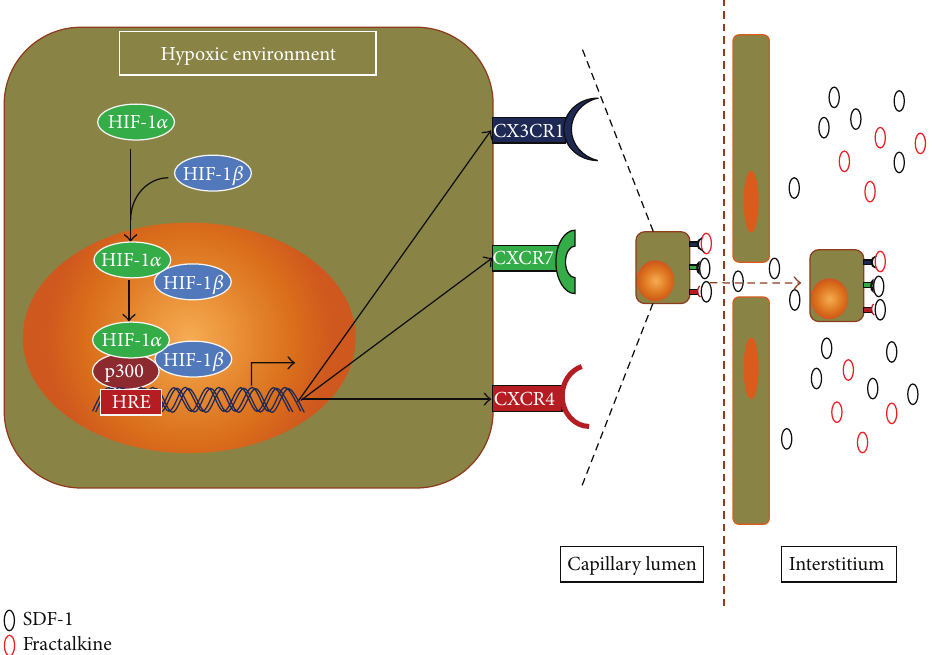
Figure 5: Upregulation of the expression of chemokine receptors by HIF-1 𝛼 in hypoxic environment to facilitate target organ-specific chemotaxis. HIF: hypoxia-inducible factor; HRE: hypoxia-response element (see text for